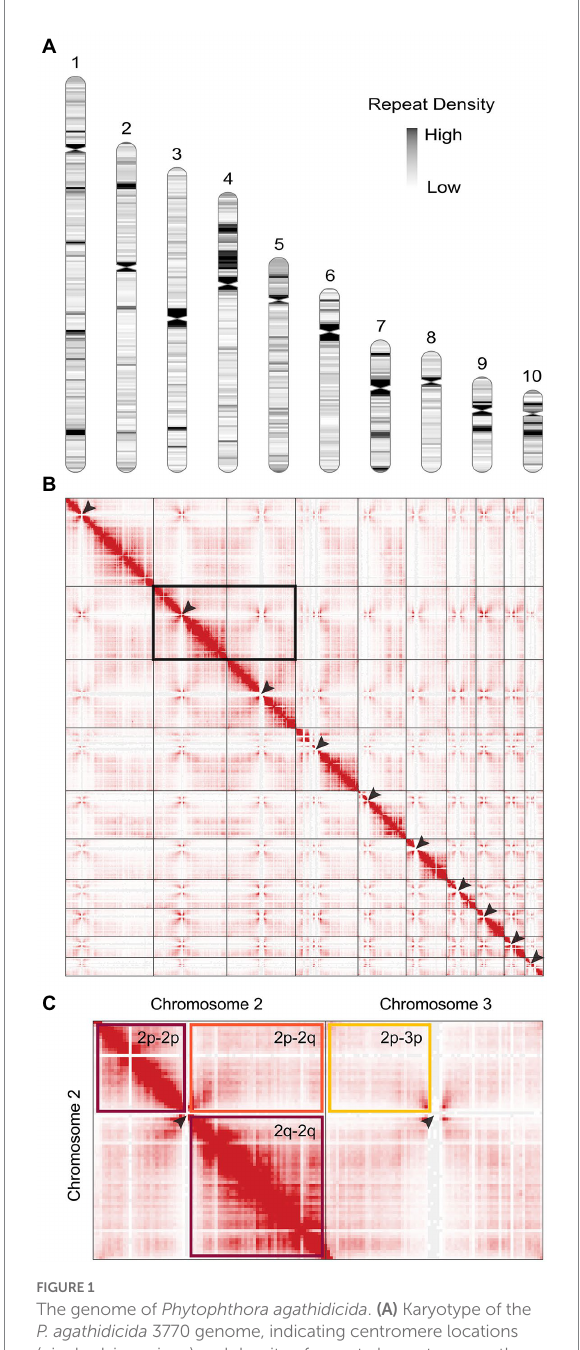
FIGURE 1 The genome of Phytophthora agathidicida . (A) Karyotype of the P. agathidicida 3770 genome, indicating centromere locations (pinched-in regions) and density of repeat elements across the ten complete chromosomes, although the full rDNA array is not depicted in chromosome 10. (B) Contact map of 3D DNA interactions within the P. agathidicida nucleus (red stippling). Arrows mark Hi-C patterns characteristic of centromere locations. (C) Enlarged example region of the DNA contact map shown in B. DNA interactions are frequent within the arms of each chromosome (maroon boxes), whilst interactions between chromosome arms are much reduced (orange box) and similar to interaction levels between different chromosomes (yellow